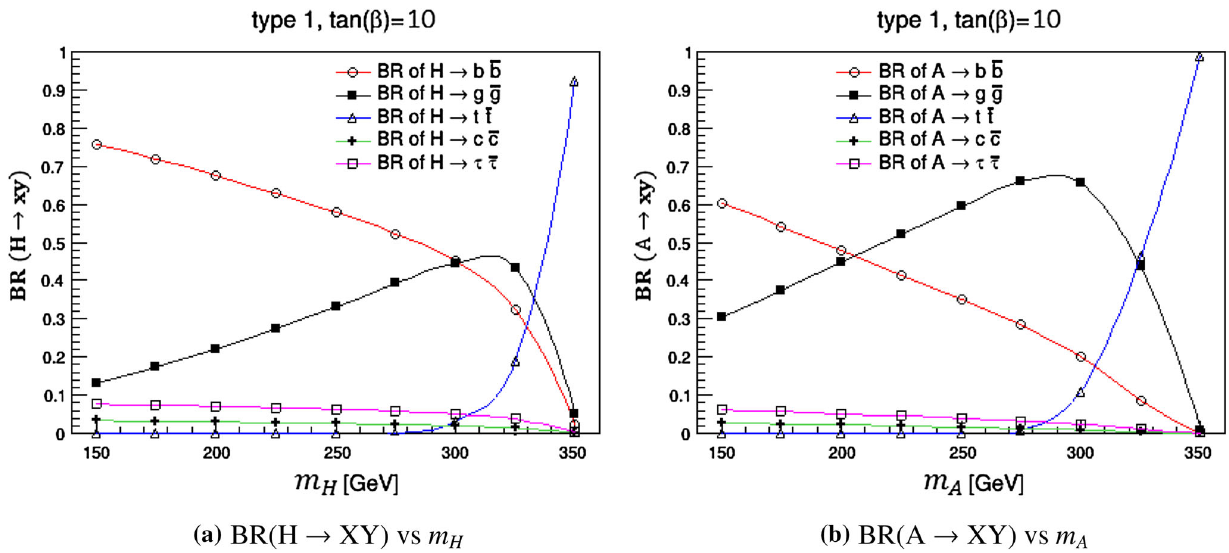
Fig. 1 The branching ratio of neutral Higgs boson decay in different channels. The tan β is set to 10